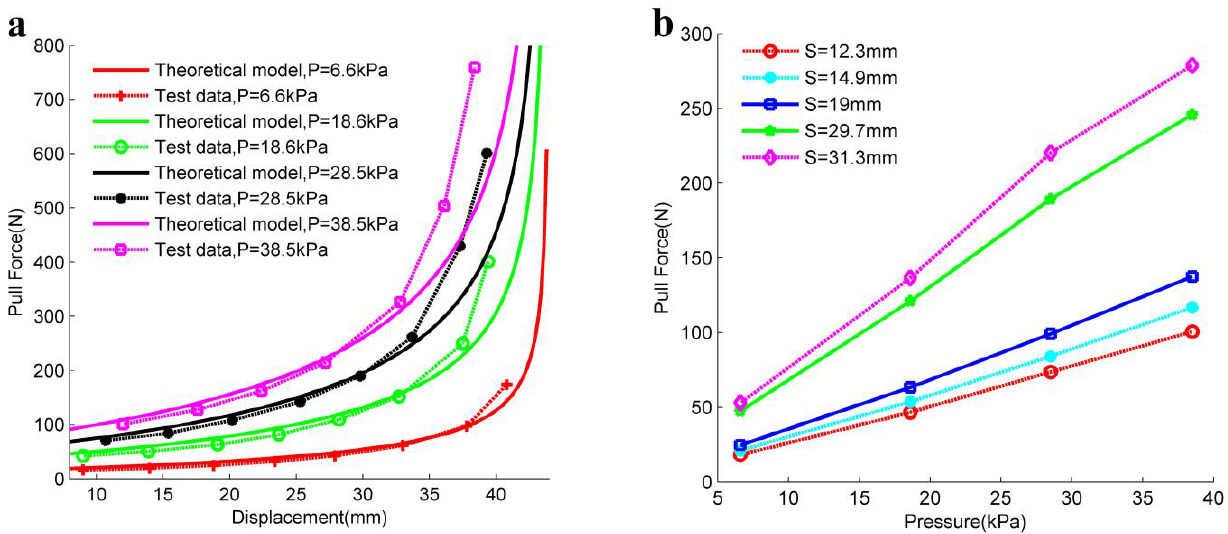
Figure 9. Test results of the PET-beamed actuator with a 3D-printed skeleton: ( a ) Force-displacement data; ( b ) Force-pressure data.